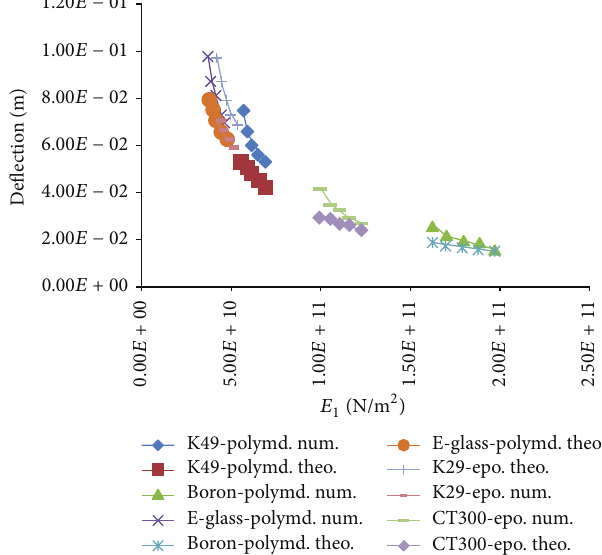
Figure 21: Comparison of numerical and theoretical results of effect of 𝐸 1 on spring deflection based on fibers variation with